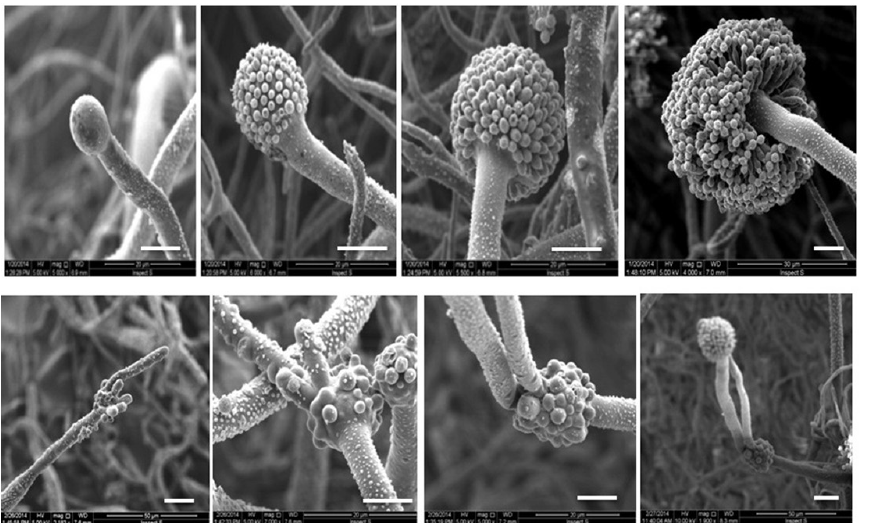
Fig. 3. Scanning electron micrographs of Aspergillus terreus. The top row shows the formation of conidiophore and conidial head on MEA medium. The bottom row shows the formation of conidiophores and the fertile and infertile vesicles on YES agar medium (Bars = 10 µ m).